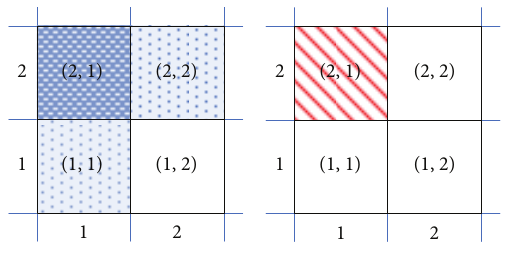
Figure 3: Air defense of naval